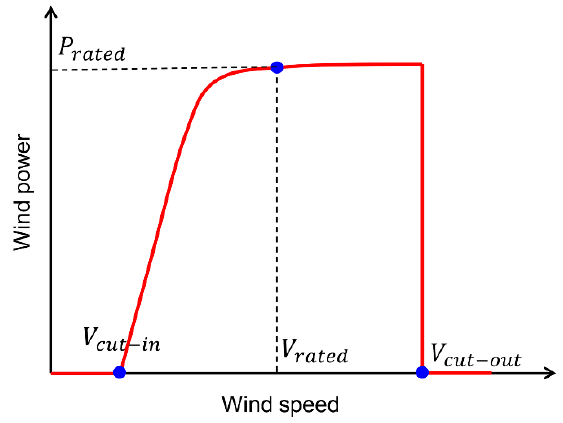
Figure 1. A typical wind turbine power curve.